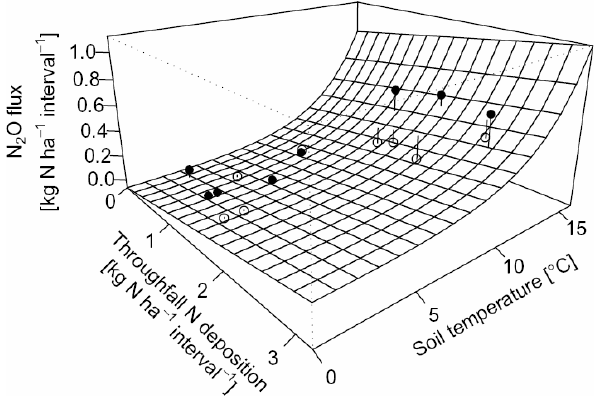
Fig. 3. Relationship between N 2 O fluxes ( y ) and total throughfall N Figure 3. Relationship between N 2 O fluxes ( y ) and total throughfall N depositions ( x ) in the 753 depositions ( x ) in the beech stand from May 2007 to June 2008 ( y = x · 0 . 25 ( ± 0.06) − 0.14 ( ± 0.09); r 2 = 0 . 53, P = 0 . 001, df = 14). beech stand from May 2007 to June 2008 ( y = x · 0.25 (± 0.06) − 0.14 (± 0.09), r 2 = 0.53, 754 P = 0.001, df = 14). 755